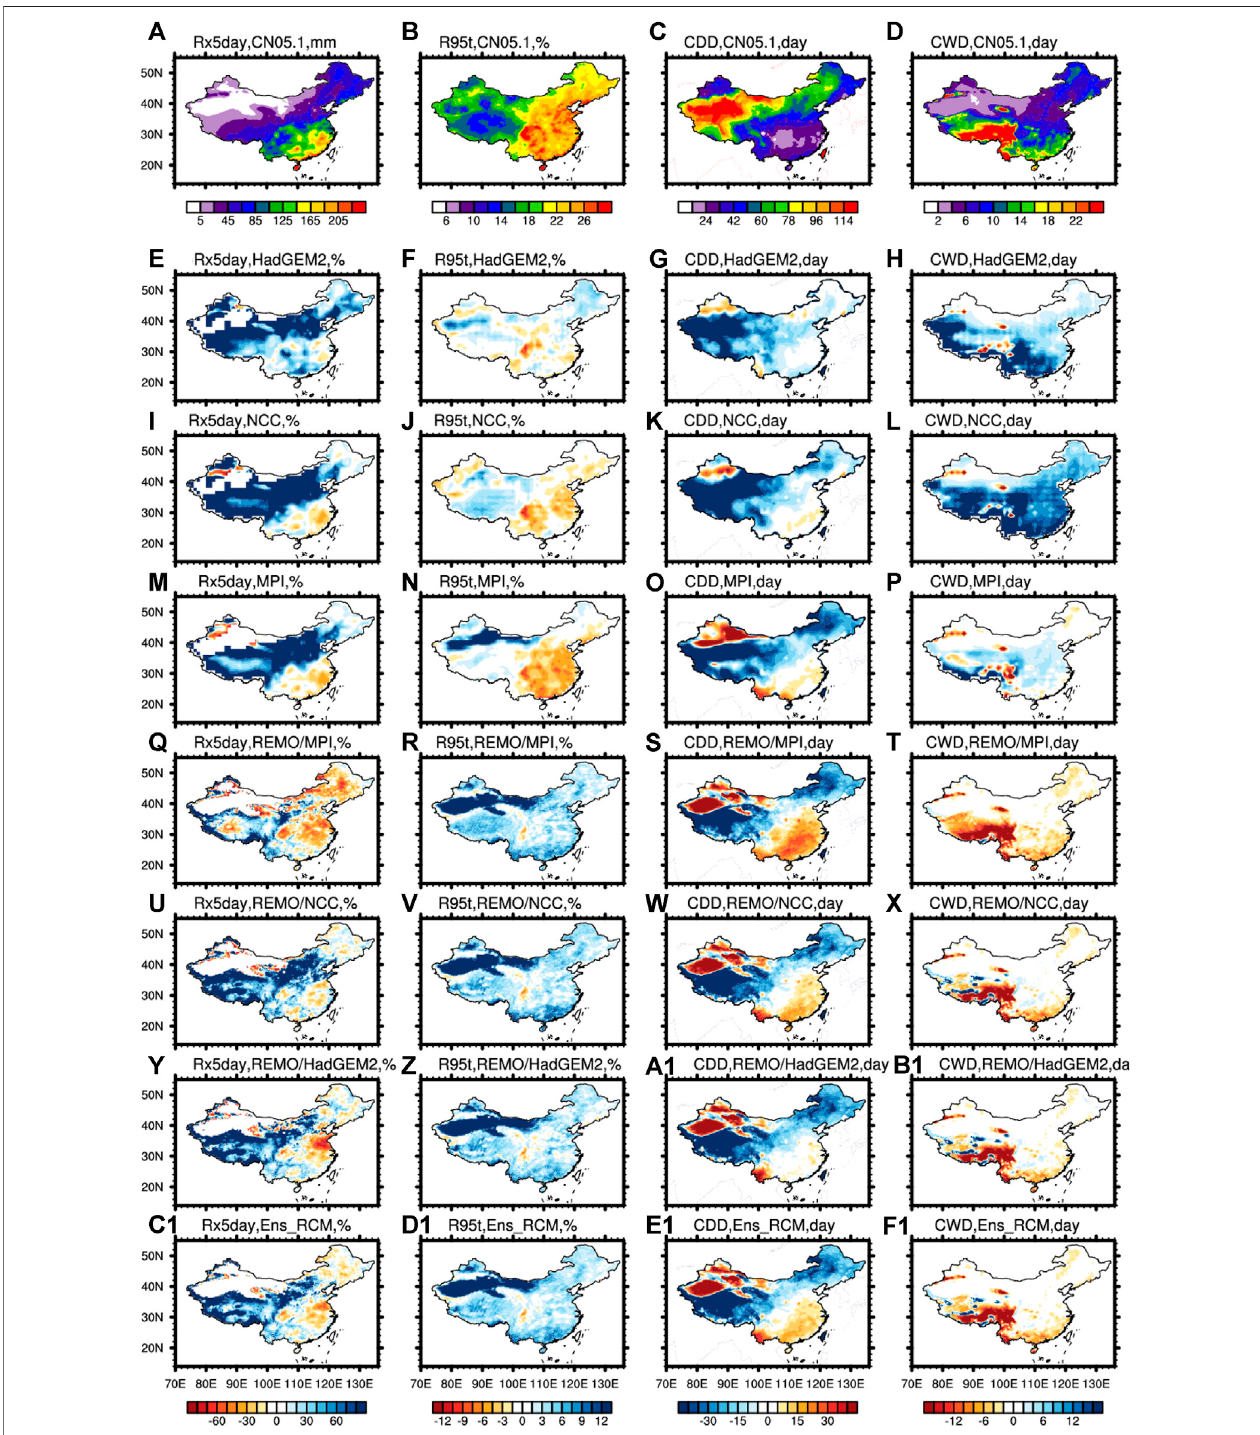
FIGURE 5 | The spatial distribution of the extreme precipitation indices in the observation (A – D) , and the deviation between each simulation and the observation. Rows 2 – 4 illustrate the deviation in the GCMs, rows 5 – 7 show the deviation in the RCM simulations, and row eight shows the deviation in the ensemble mean.